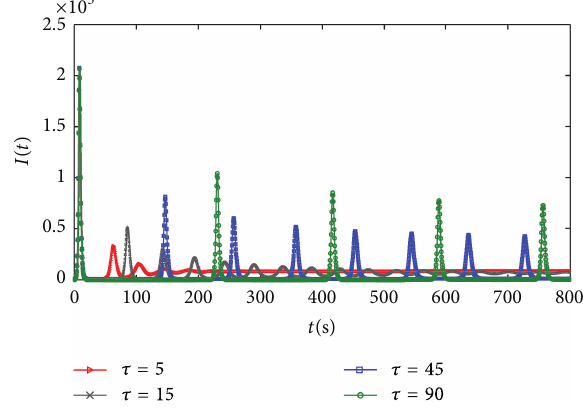
Figure 6: The number of 𝐼(𝑡) when 𝜏 is